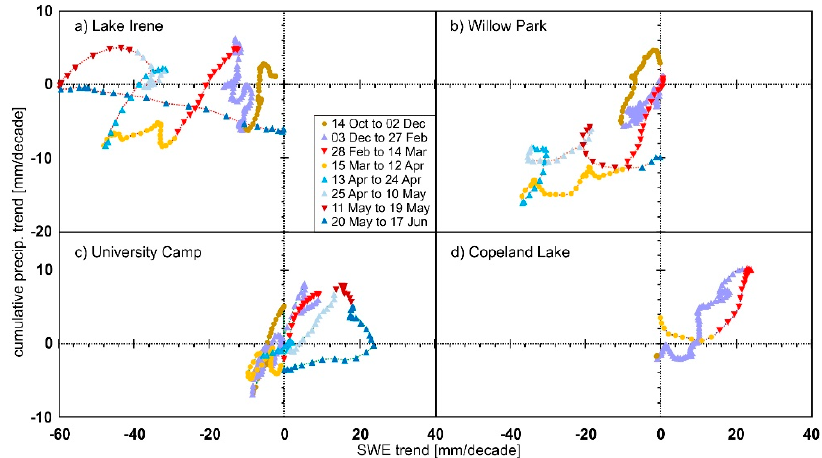
Figure 10. Seven-day running average cumulative precipitation trend versus SWE trend, as per Figure 9b for ( a ) Lake Irene, ( b ) Willow Park, ( c ) University Camp, and ( d ) Copeland Lake, divided into the periods identified in Figures 8a,c.